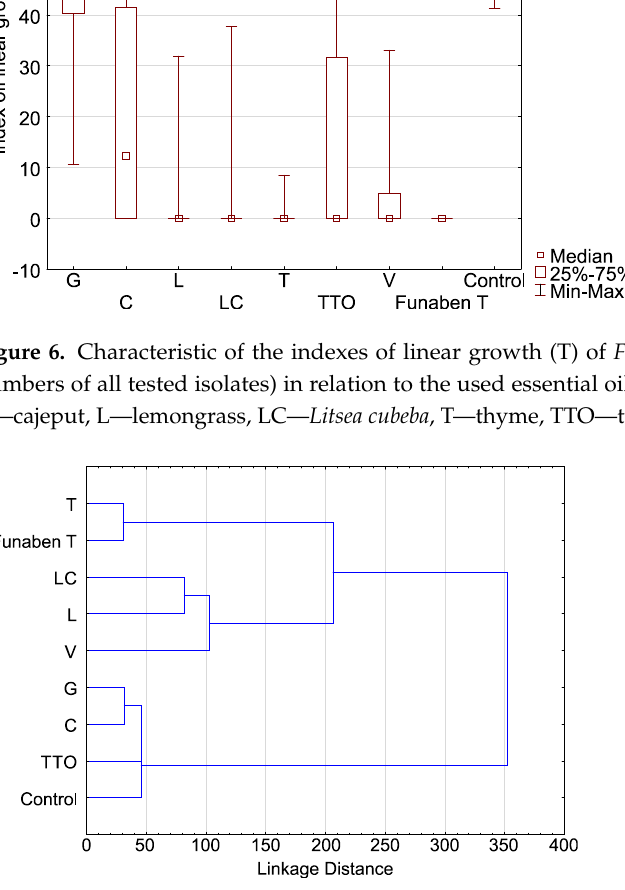
Figure 6. Characteristic of the indexes of linear growth (T) of Fusarium spp. isolates (aggregate num-